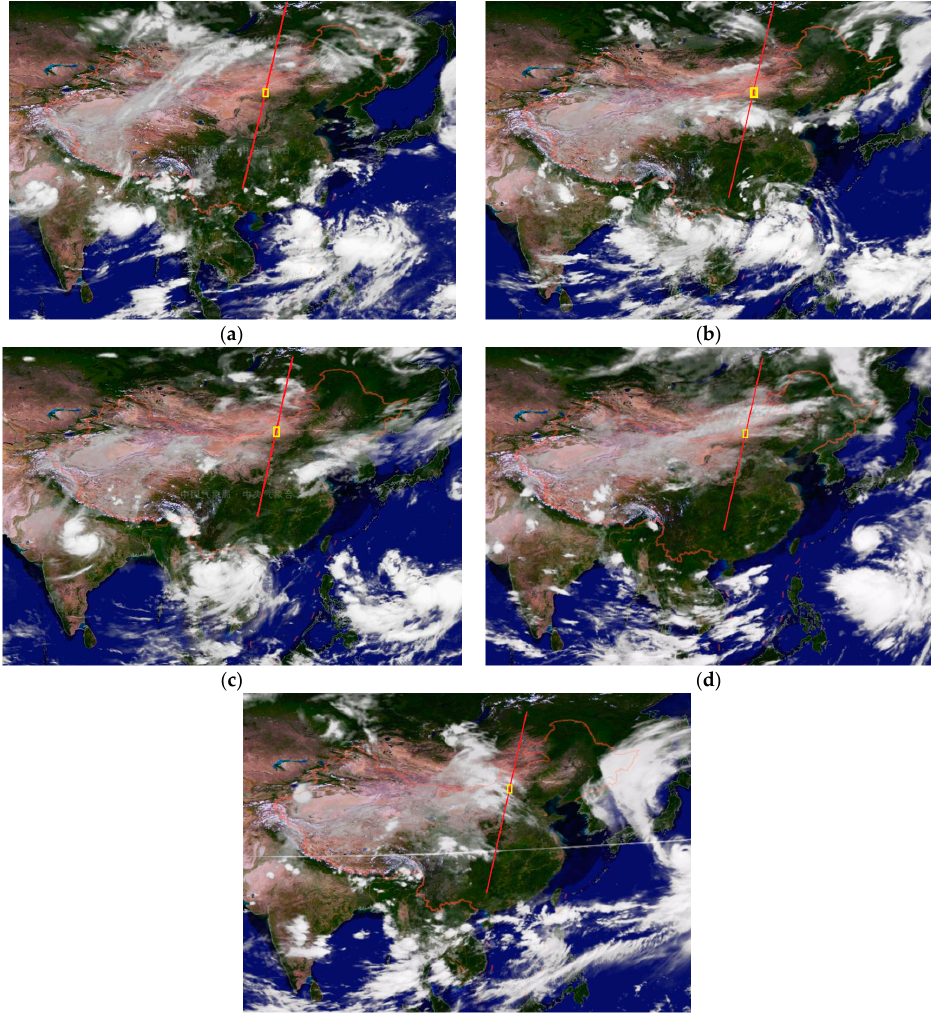
Figure 12. The five nephograms from the test period: ( a ) 9 August; ( b ) 14 August; ( c ) 19 August; ( d ) 24 August; and ( e ) 29 August. The red line is the satellite laser sub-point, and the yellow frame is the test alternative region.